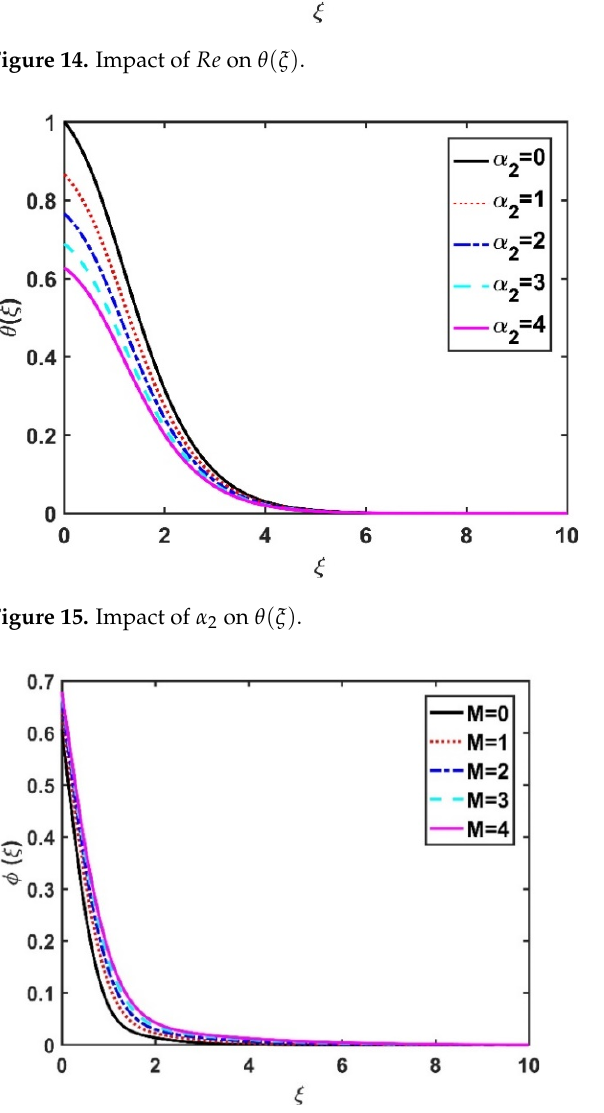
Figure 17. Impact of 𝑚 on 𝜙(cid:4666)𝜉(cid:4667) . Figure 18. Impact of 𝑁𝑏 on 𝜙(cid:4666)𝜉(cid:4667) .